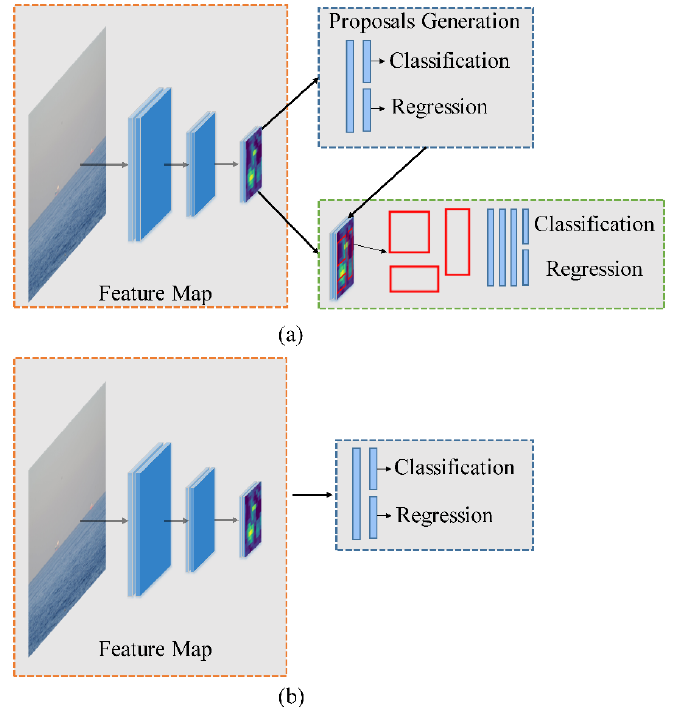
Figure 5. ( a ) Two-stage detector, which is composed of a backbone network, region proposal network, and detection network. ( b ) One-stage detector that predicts the bounding box directly from the input image.